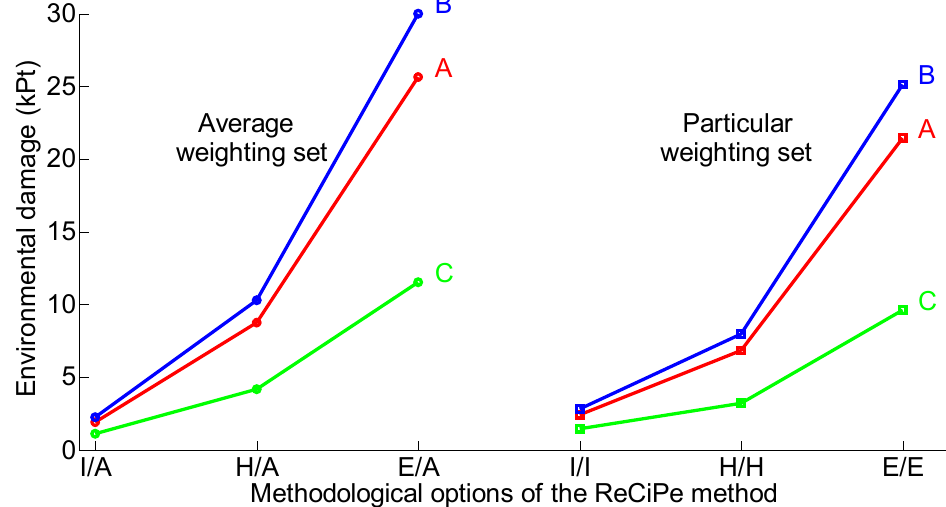
Figure 10. Environmental damage from three retrofitting measures—(A) Case 1, (B) Case 2, and (C) Case 3—evaluated using the ReCiPe 2016 endpoint single-score method.